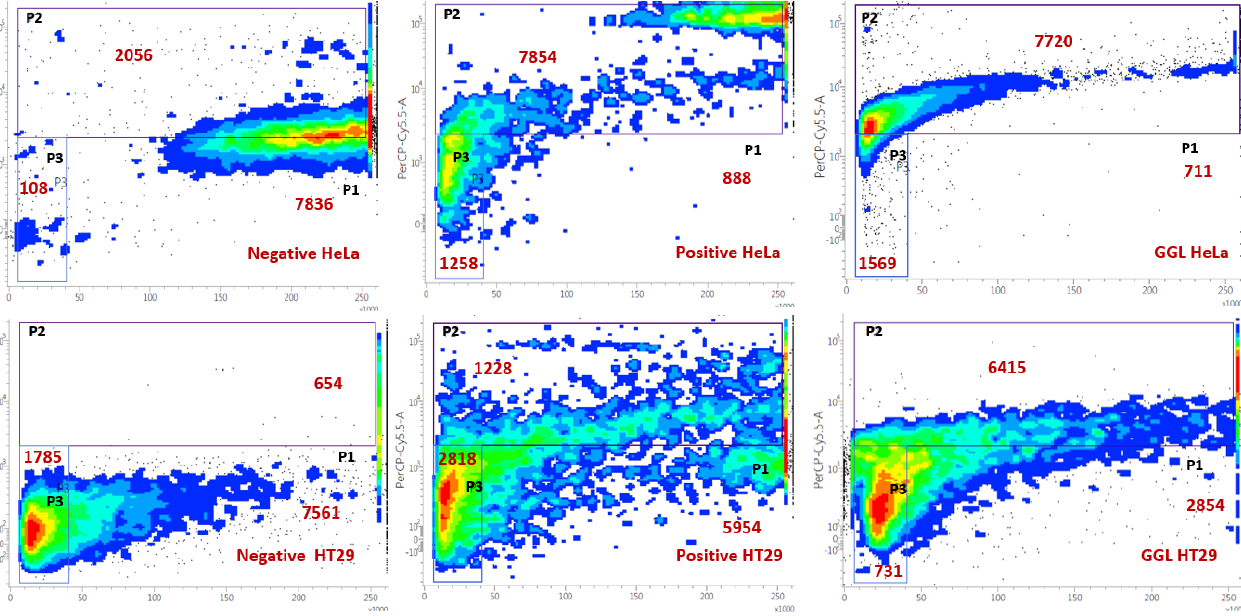
Figure 2. Percentage cell viability of cell lines treated with plant extracts at 500 µg/mL concentration. One—way ANOVA test indicated a significant difference ( p -value < 0.05) in cytotoxicity between the different plant extracts for the same cell line, denoted by different letters on the respective bars. Negative control: cells without treatment; positive control: cells treated with 50 µg/mL cisplatin (chemotherapy drug).